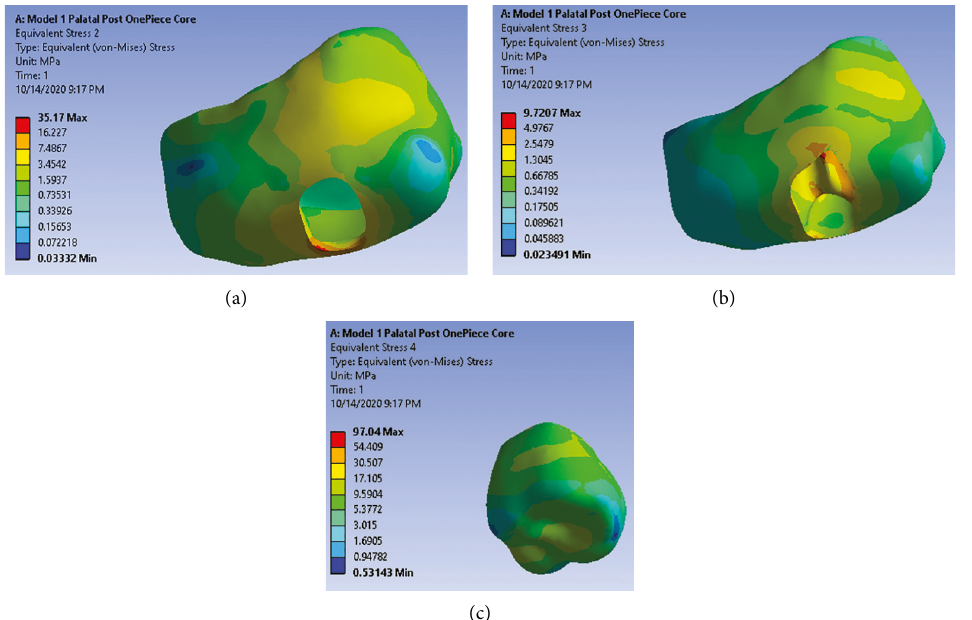
Figure 7: (a) Stress distribution pattern in cortical bone. (b) Stress distribution pattern in spongy bone. (c) Stress distribution pattern in